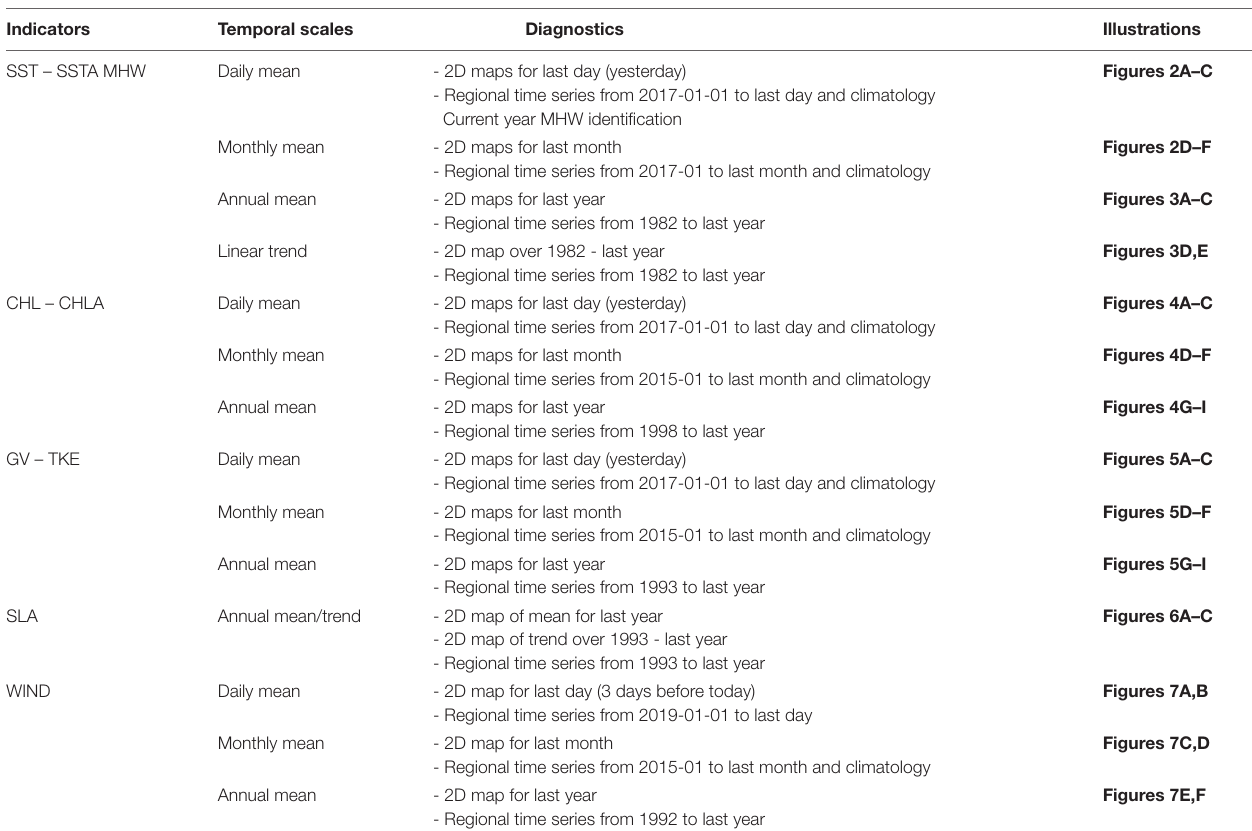
TABLE 3 | Summary of the diagnostics and illustrations for the surface ocean indicators.